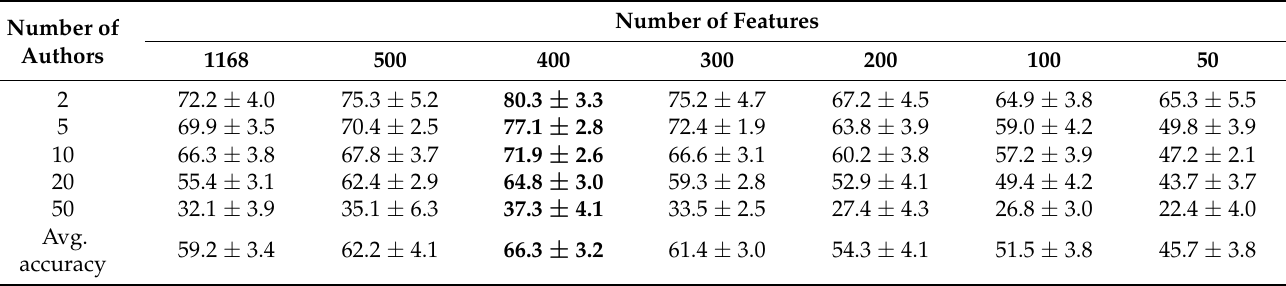
Table 11. Results of GA for social media texts dataset.